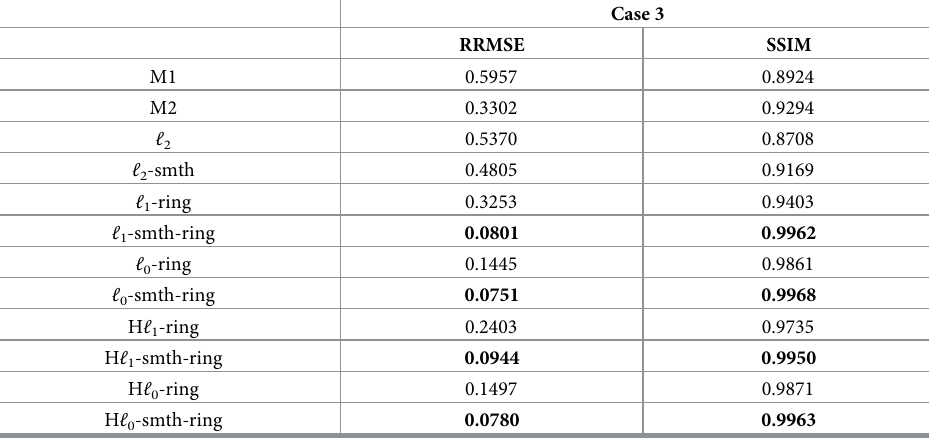
Table 3. RRMSE and SSIM values of reconstructed images by the proposed algorithms and the compared methods for the third study